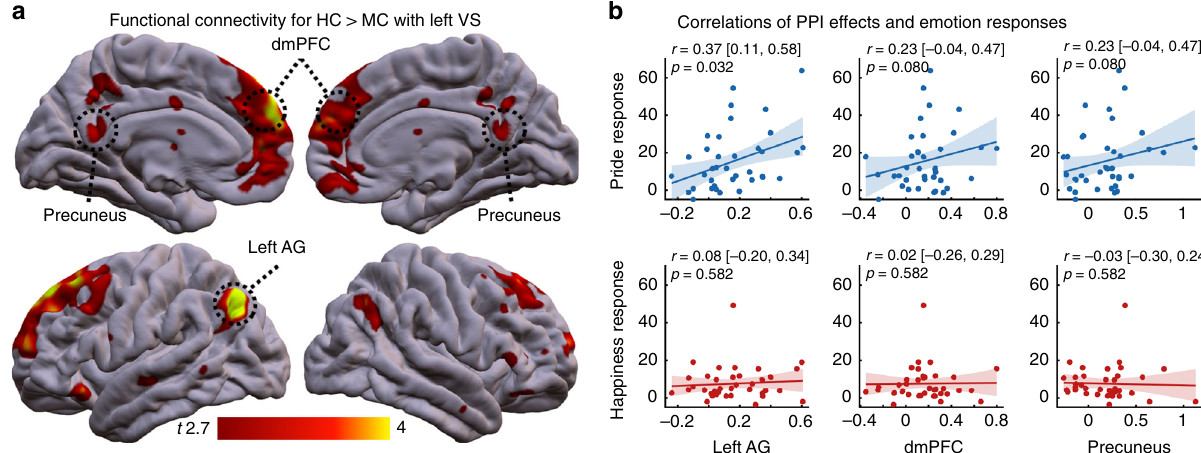
Fig. 6 Connectivity dynamics of left VS for outcomes obtained under high internal control. a ROI analysis showed increased coupling between left VS and the left AG, the dmPFC and precuneus (small-volume FWE-corrected at p < 0.05). Effects are displayed at p < 0.005, whole-brain, for illustrative purposes. See supplements for full connectivity coordinates. b Bivariate correlations between pride (top) and happiness (bottom) response (i.e., [HC: WIN – HC:noWIN] – [MC:WIN – MC:noWIN]) and estimates of functional connectivity from left AG, dmPFC, and precuneus. Eigenvariates of clusters within the SELF ¬ VALUE mask consisting of voxels showing signi fi cantly increased functional connectivity with VS at p < 0.0005 (uncorrected) were computed for the three regions highlighted in A. p -values are one-sided and false-discovery rate corrected. r = Pearson correlation coef fi cient. Values in brackets are 90% con fi dence intervals, and shaded areas represent 95% con fi dence intervals. Source data are provided as a Source Data fi